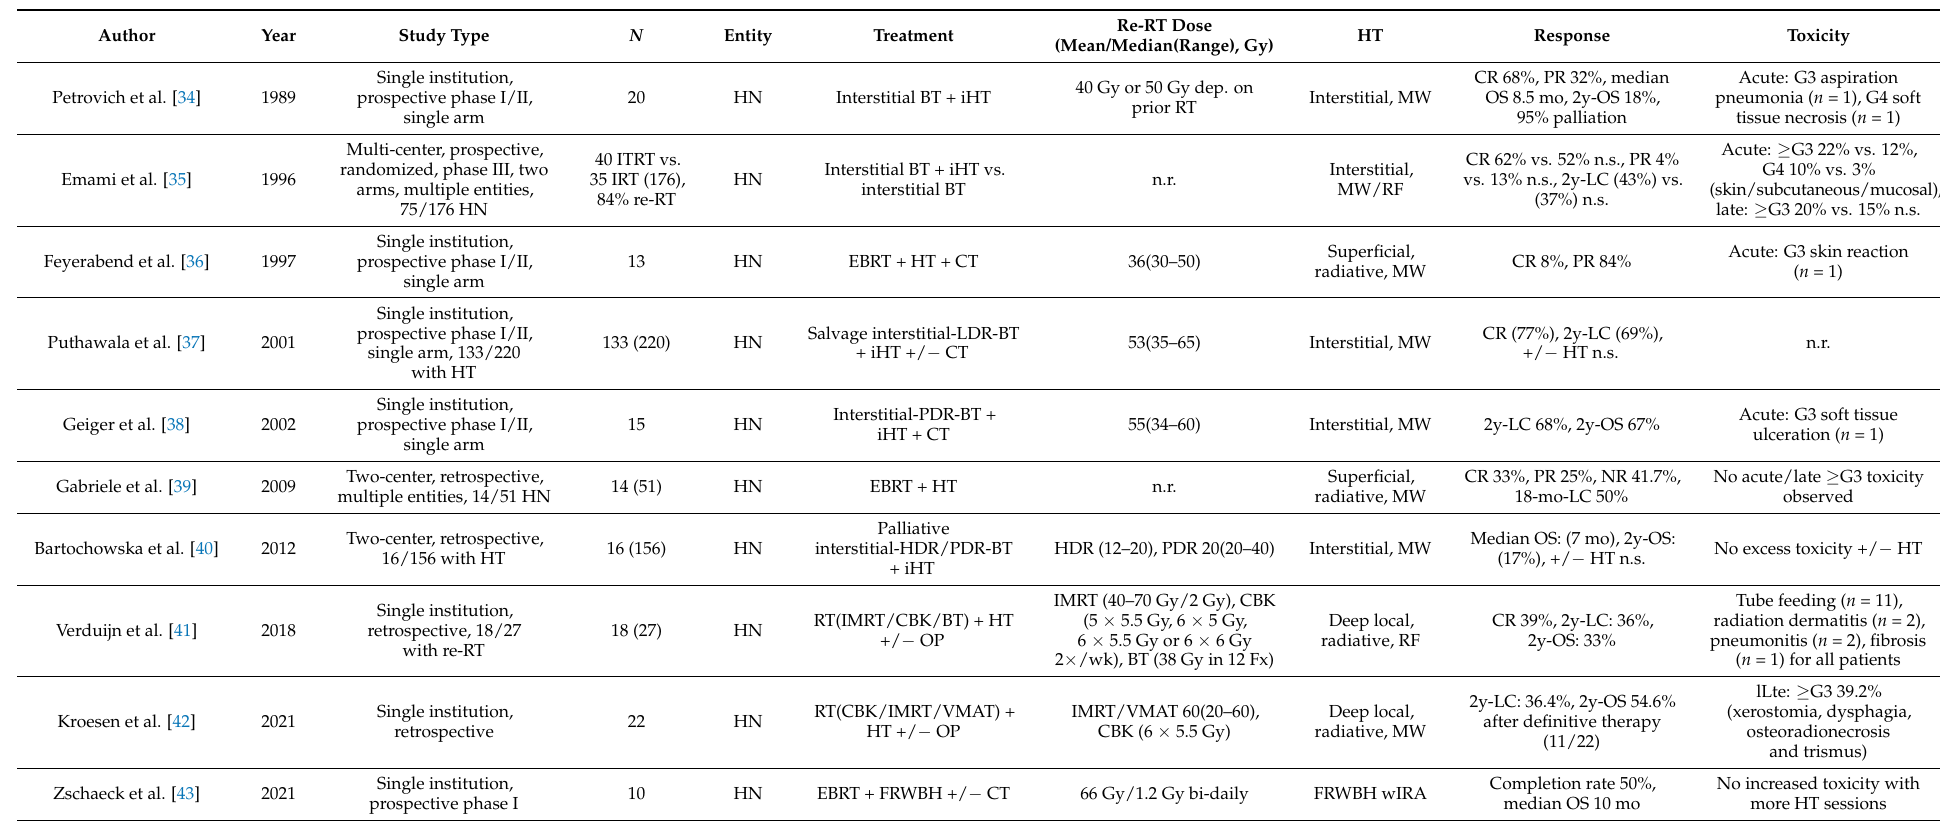
Table 2. Head and neck